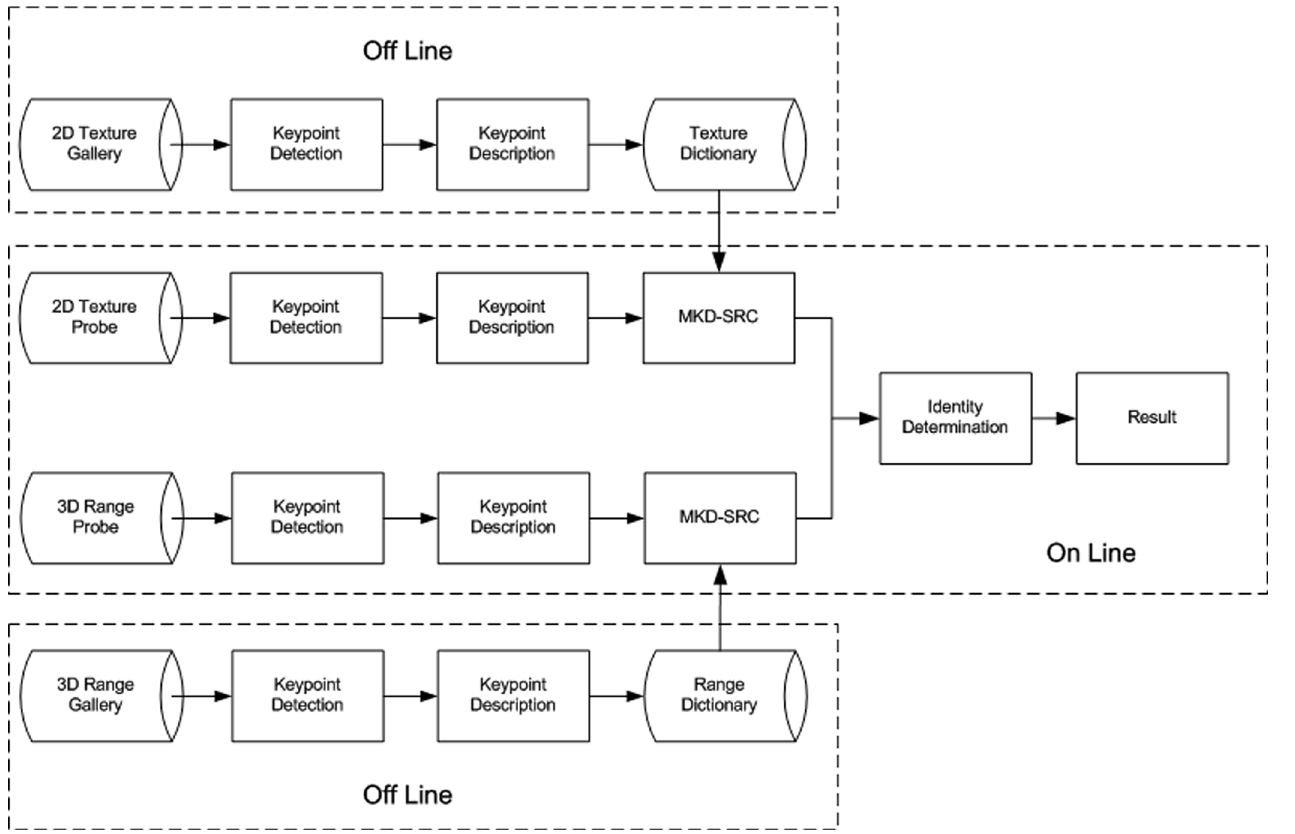
Fig 1. Overall flowchart of hybrid